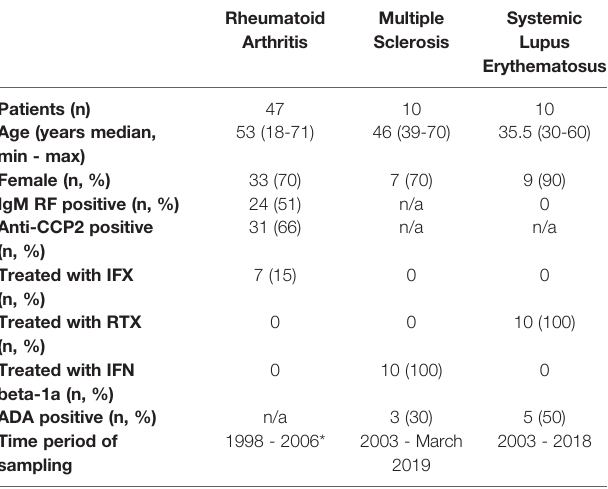
TABLE 1 | Patients ’